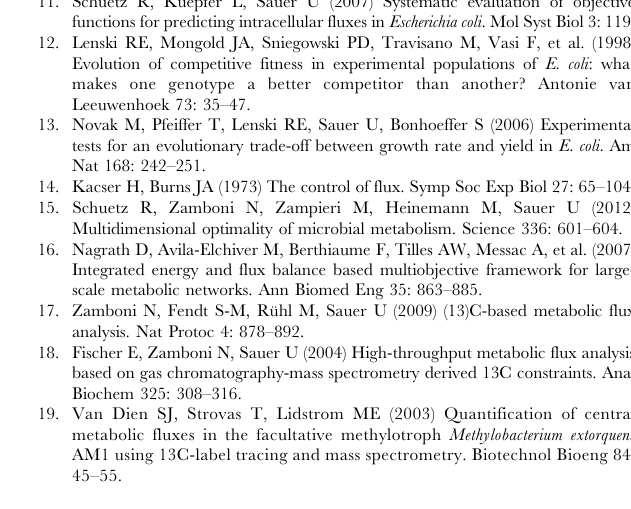
displayed for growth parameters, and flux ratios. Additionally, data is displayed about the normality of % optimality and distance for different criteria. Figure S4 Measures of optimality based upon BM/ S v or ATP/ S v for all data sets. (A,B,E,F,I,J) The % optimality of the ancestor (black) and evolved isolates (grey); (C,D,G,H,K,L) distance to optimal flux distribution for FBA-predictions (plotted as log(D EO /D AO )). These were performed based upon BM/ S v (A,C,E,G,I,K) or ATP/ S v (B,D,F,H,J,L). The data sets are LTEE (A–D), lactate (E–H), and KO (I–L). Error bars for LTEE represent standard errors of three biological replicates. Figure S5 Measures of optimality based on maximizing the tradeoff between BM, ATP and S v for all data sets. The Pareto distance of the ancestor (black) and evolved isolates (grey) for LTEE (A), lactate (B), and KO (C). Error bars represent standard errors of three biological replicates. Figure S6 Implementation of oxygen constraints. Fol- lowing the example of Schuetz et al 2007 [11] we varied the ancestral oxygen uptake rate across the range reported in the literature (11.5–14.75 mmol/g hr). Ibarra et al 2002 [24] report that the ratio of oxygen to glucose uptake remains largely constant as cells evolve. We tested the impact of varying ancestral oxygen/ glucose ratio as well as the slope of evolutionary change from 0.5 to 1.5. There was no significant difference in the change in % optimality for either BM/S (A) or ATP/S (B) across this wide range of parameter values. Results are not presented for an ancestral oxygen uptake rate of 11.5 for ATP/S because this constraint caused infeasible solutions for several evolved popula- tions. Results obtained with the default values used throughout the manuscript, an ancestral uptake of 14.75 mmol/g hr and a slope of 1, are highlighted in red. Figure S7 The effect that potential evolution of con- straints would have on average change in % optimality between ancestor and evolved lines. A) Lipid content was altered in evolved lines from 80–120% of the default values. B) Maintenance energy in evolved lines was altered from 50–150% of the default value of 8.39 mmol/g hr. Analyses for ATP/S are not